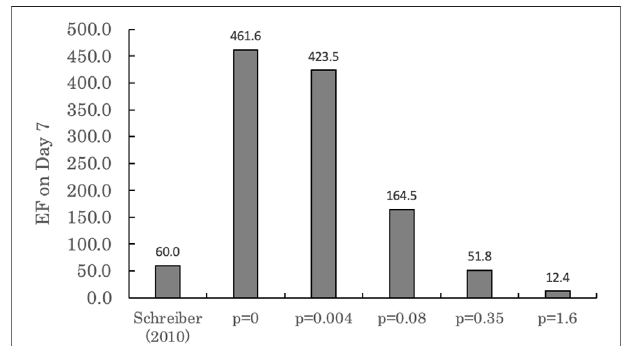
FIGURE4| Enrichmentfactor(EF)onday7ascalculatedbytheIV-MBM DP v1.0 model for Schreiber et al., 2010 with varying K DOM proportionality constants ( p ). Where p = 0.004 and p = 1.6 are the lower and upper limits of the95%con fi denceintervalof p =0.08(Burkhard,2000),and p =0.35is the proportionality constant to dissolved organic carbon (Seth et al.,